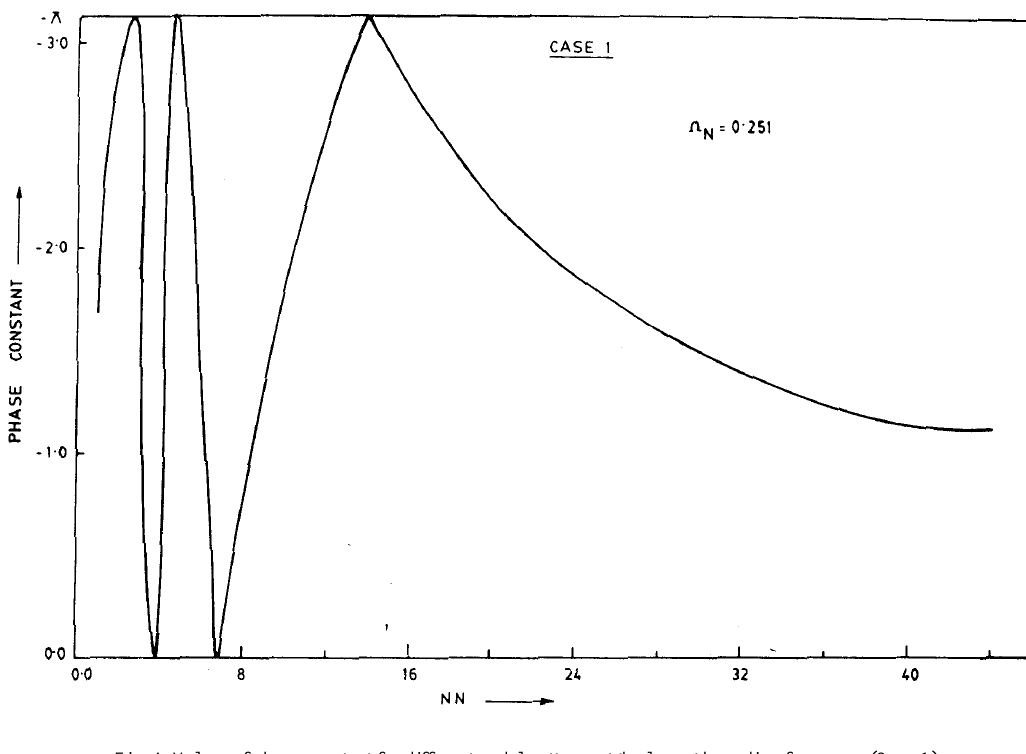
Fig. 4. Values of phase constant for different nodal patterns at the lowest bounding frequency (Case